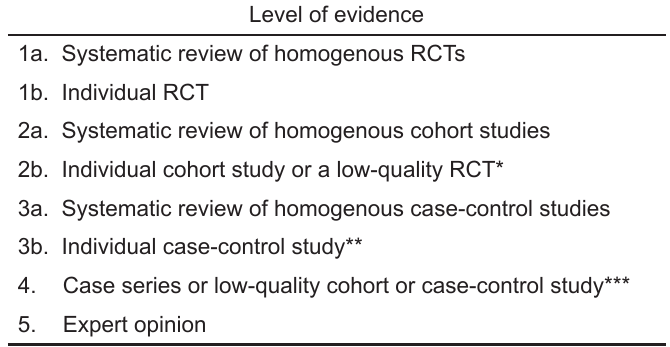
RCT, randomized controlled trial. *Defined as <80% follow up; ** includes survey studies; ***defined as studies without clearly defined study groups.